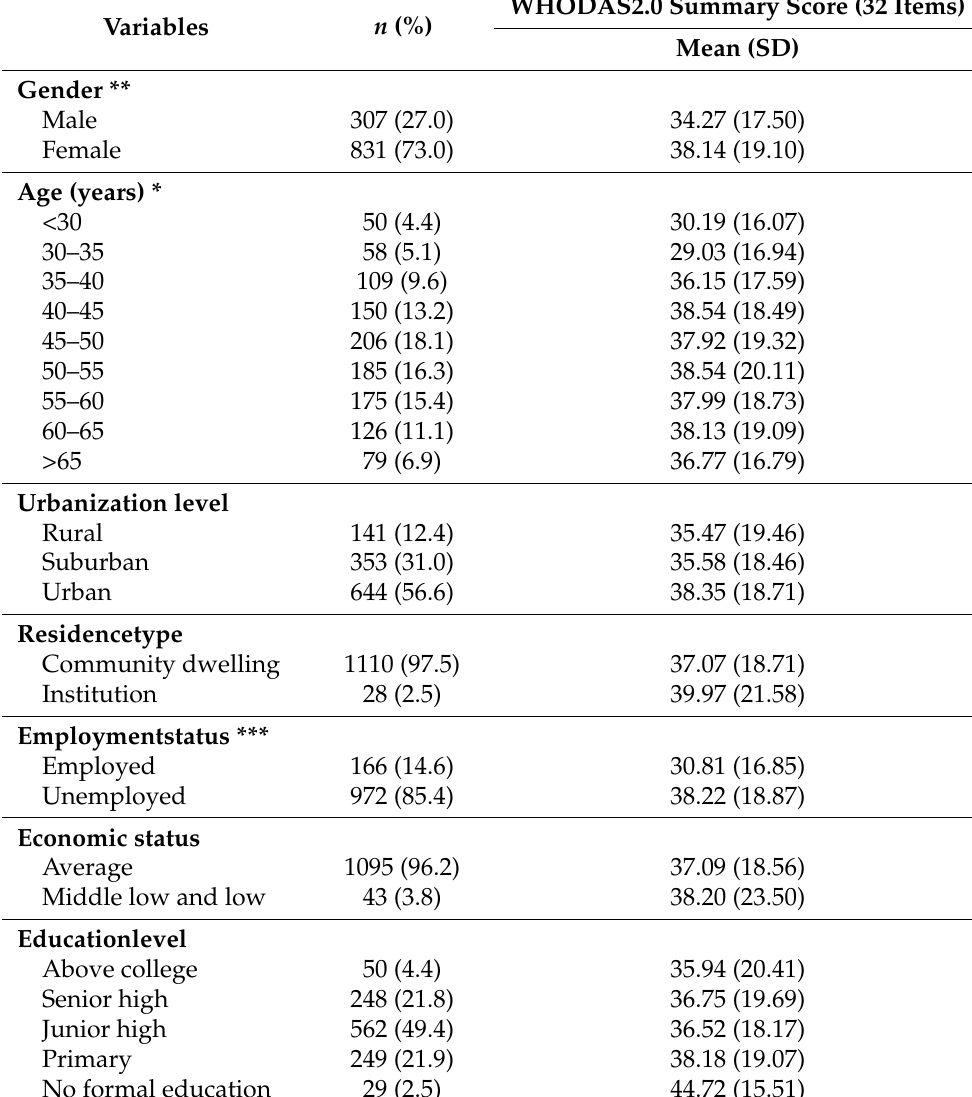
Table 1. Sociodemographic characteristics of depressive patients in Taiwan ( n = 1138).